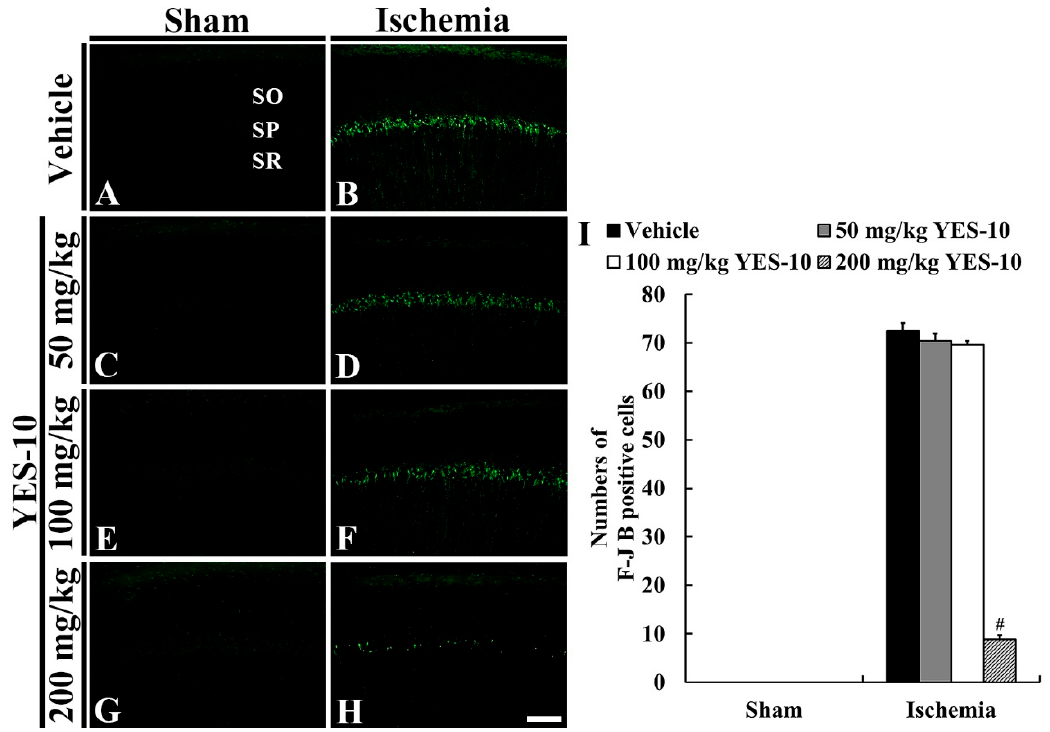
Figure 3. F-J B histofluorescence staining in the CA1 field of the vehicle/sham ( A ), 50 mg/kg YES-10/sham ( C ), 100 mg/kg YES-10/sham ( E ), 200 mg/kg YES-10/sham ( G ), vehicle/ischemia ( B ), 50 mg/kg YES-10/ischemia ( D ), 100 mg/kg YES-10/ischemia ( F ) and 200 mg/kg YES-10/ischemia ( H ) groups at 5 days post-ischemia. F-J B positive CA1 pyramidal cells were found in the vehicle, 50 and 100 mg/kg YES-10/ischemia groups. However, F-J B positive CA1 pyramidal cells were rarely observed in the 200 mg/kg YES-10/ischemia group. Scale bar = 100 μ m. ( I ) The mean number of F-J B positive CA1 pyramidal cells at 5 days post-ischemia (n = 7 in each group, # P < 0.05 versus vehicle/ischemia group). The bars indicate the means ± SEM.